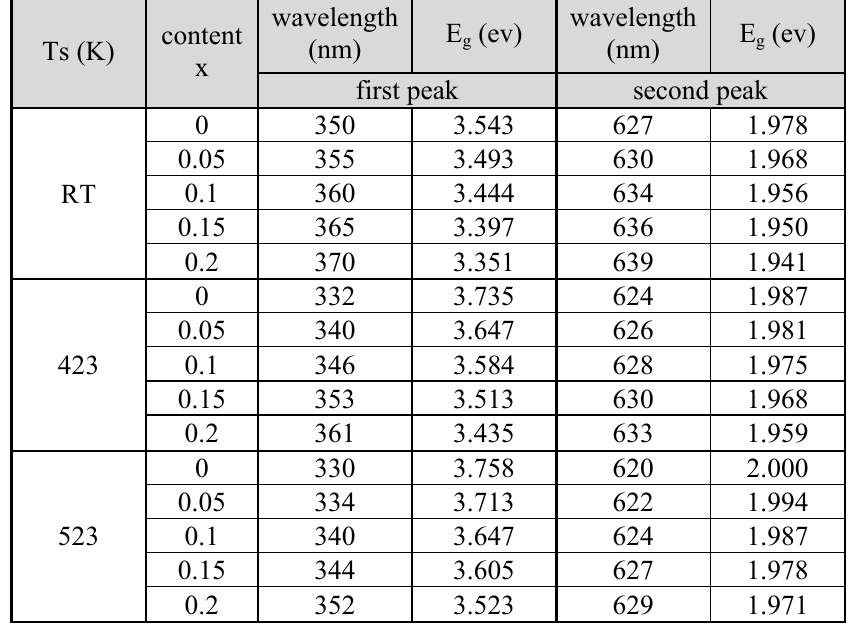
Table 2: The peak values and the energy of the luminescence spectrum of all